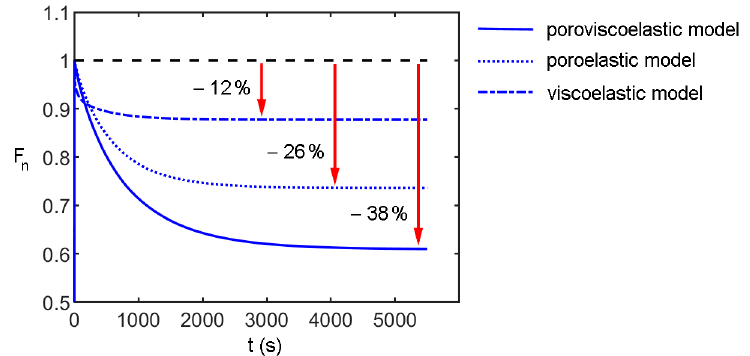
Figure 6. Comparison of the effects of different constitutive models on the consolidation behavior: the major reduction of normalized indentation force occurs at different characteristic times and with different variations marked by red arrows.